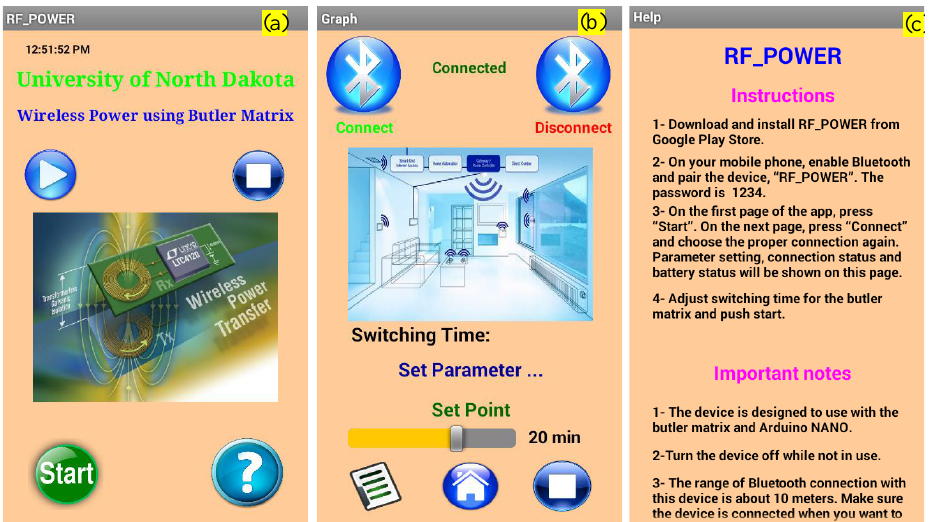
Figure 25. Mobile app for the RF power transfer system design. ( a ) Frontpage, ( b ) Timer set, and Bluetooth connection page, ( c ) Instruction